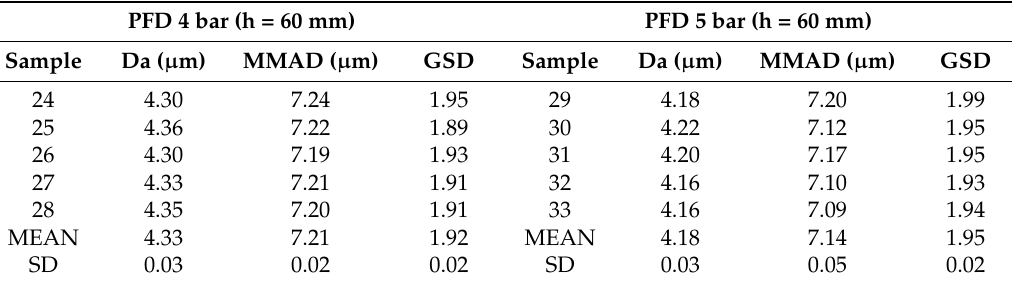
Table 3. PFD experimental results at h = 60